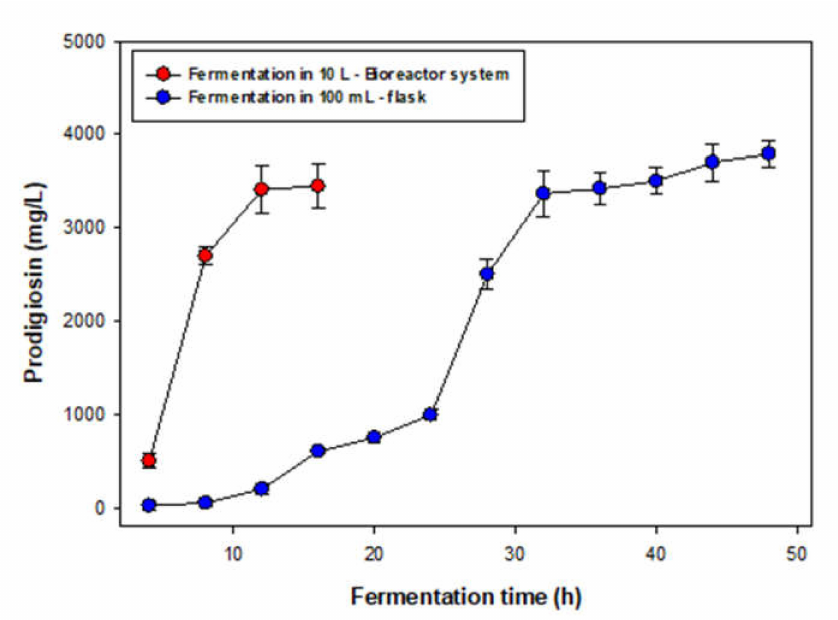
Figure 4. PG production by S. marcescens TNU01 in 10 L bioreactor systems and in a 100 mL-flask. An amount of 300 mL of seed bacteria was prepared in a flask for 1.5 days and injected in 10L bioreactor systems containing 3 L of liquid medium with other optimized compositions of other parameters as obtained from Section 3.2. The medium was sampled, and PG was detected from 4 to 16 h of fermentation. PG production also by S. marcescens TNU01 in optimal conditions in a 100 mL